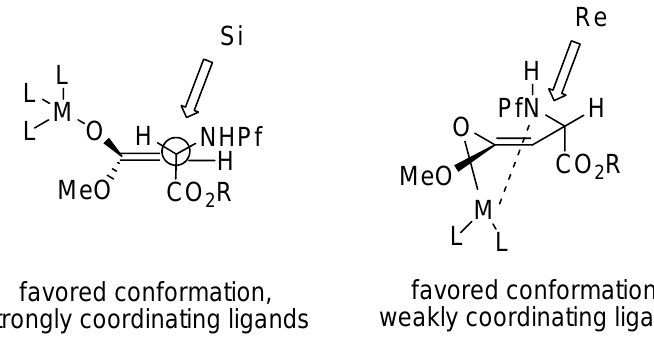
Figure 5. Transition state models for